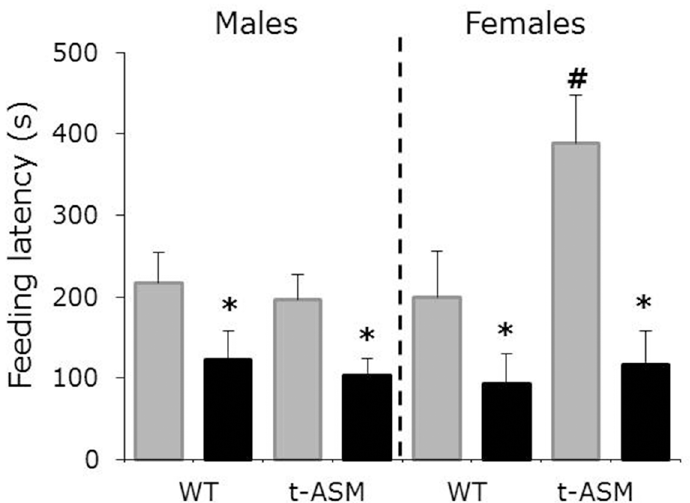
Fig 3. ASM overexpression increased depressive- and anxiety-like behavior in female, but not in male, mice. Feeding latency in a novel arena after a fasting period of 24 h. Mice were treated with amitriptyline (black bars) or water (grey bars) for 4 weeks before and during behavioral testing (n = 10 – 13 per group). Shown are means + SEM. p < 0.05 * versus water-treated mice; # versus WT mice.